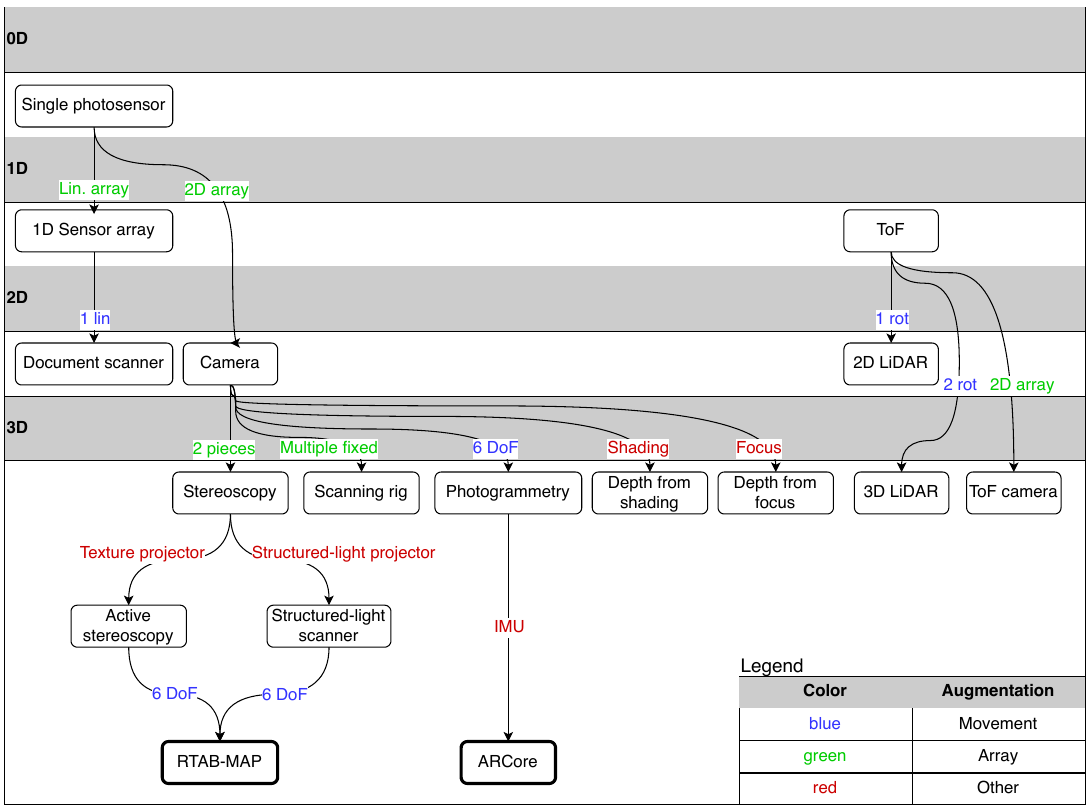
Figure 1. A summary of optical